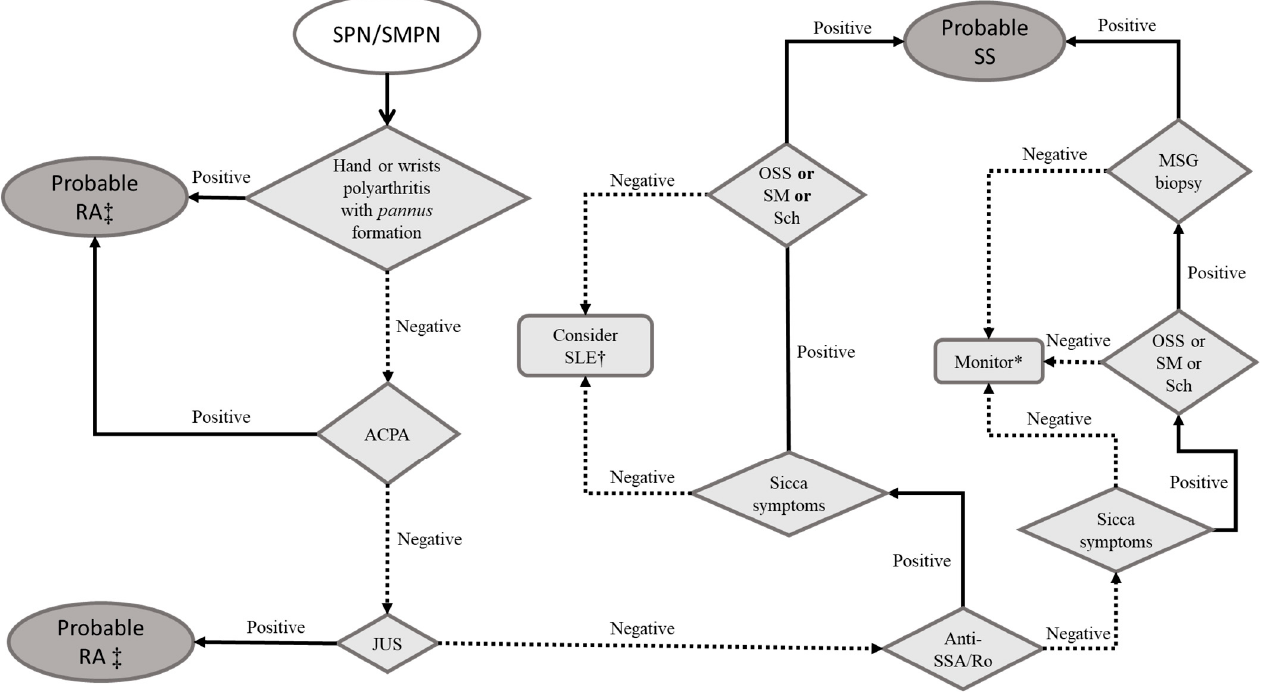
Figure 2. Proposed approach for the patient with pure sensory polyneuropathy (except isolated small fiber neuropathy) or sensorimotor polyneuropathy. Notes: Anti-SSA/Ro is the main autoantibody related to Sjögren’s syndrome and part of the contemporary diagnostic criteria. Sicca symptoms refer to the complaints related to dryness of the mouth, eyes, skin, and genital and respiratory tracts. Legend: ACPA: anti-cyclic citrullinated peptide antibody; JUS: joint ultrasound; MSG: minor salivary gland; OSS: ocular staining score (ophthalmic exam with specific dyes aiming to document and quantify eye surface’s desepithelization); RA: rheumatoid arthritis; Sch: Schirmer’s test (quantification of lacrimal flow volume by time unit); SPN/SMPN: sensory polyneuropathy/sensorimotor polyneuropathy; SLE: systemic lupus erythematosus; SM: unstimulated sialometry (simple quantification of salivary flow volume by time unit); SS: Sjögren’s syndrome. * Treat neuropathy (see text) and either: (1) order anti-Sm and anti-DNA for systemic lupus erythematosus; (2) order antineutrophil cytoplasmic antibody for systemic vasculitides; or (3) reassess in 6 months. † Consider testing for anti-DNA and anti-Sm. ‡ Order rheumatoid factor and anti-cyclic citrullinated peptide antibody (if not carried out yet) for prognostic purposes.